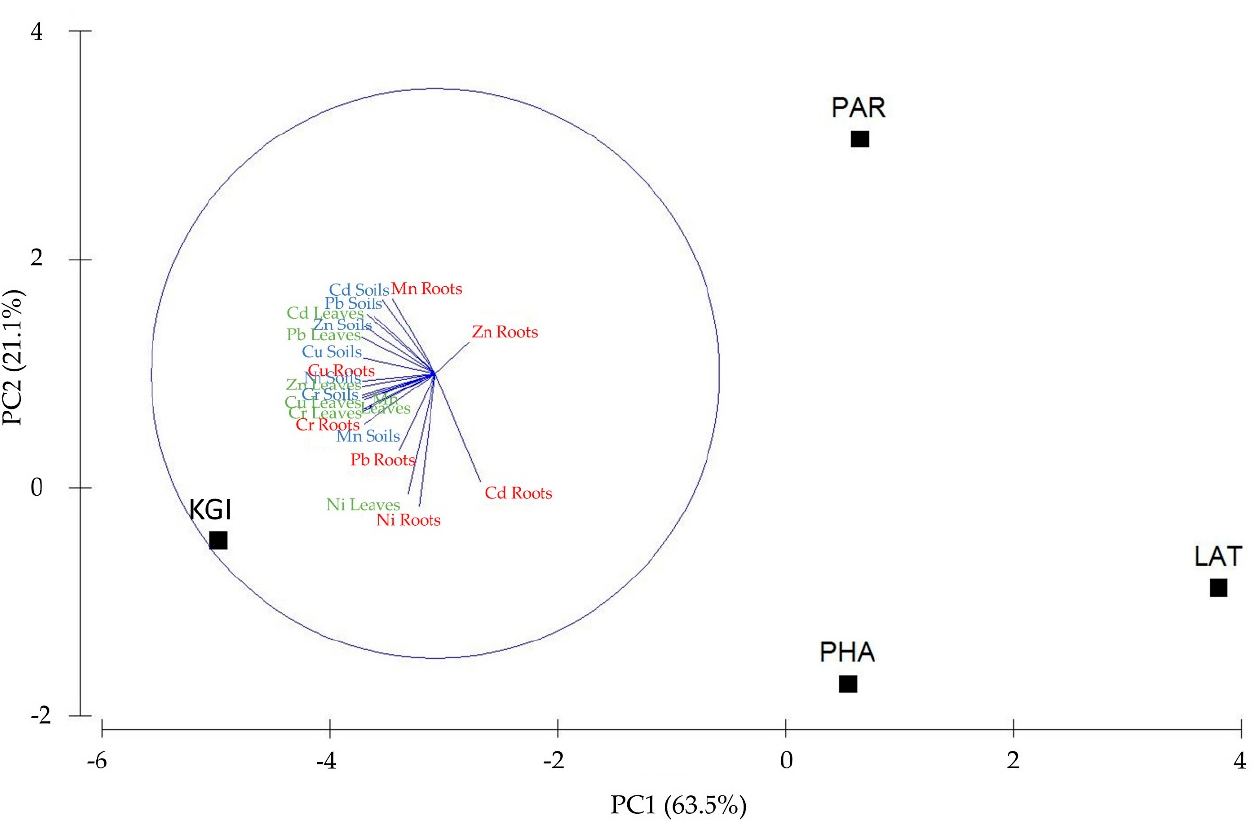
Figure 4. Principal component analysis (PCA) of MTEs in the leaves (green color); roots (red color) of Colobanthus quitensis ; and soils (blue color) from Lagotellerie Island (LAT), Hannah Point Peninsula (PHA), King George Island (KGI), and Punta Arenas (PAR).